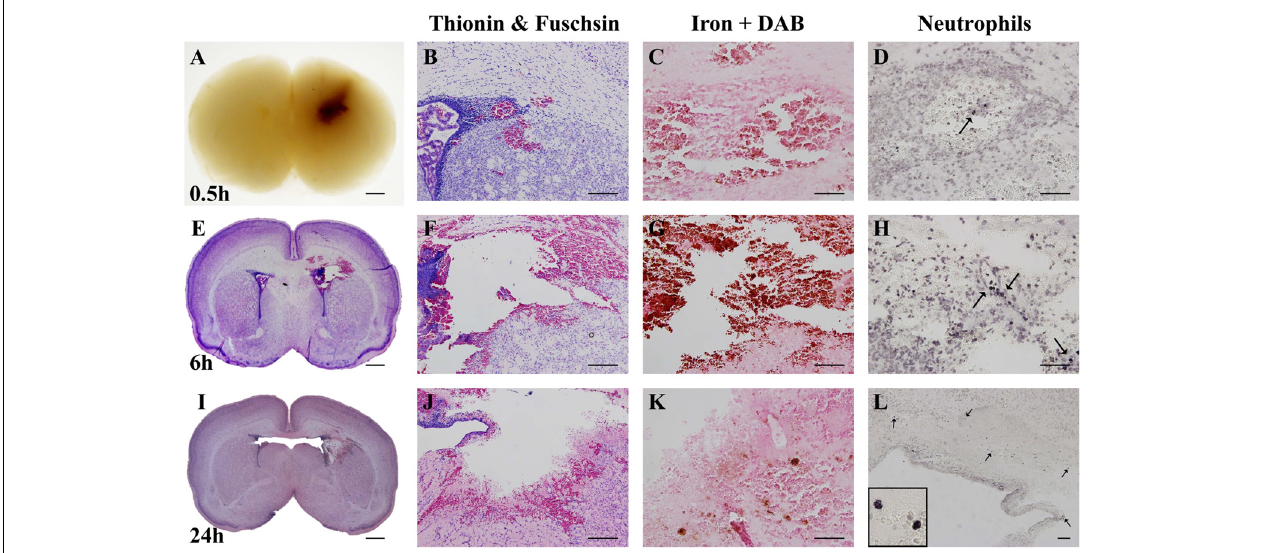
FIGURE 2 | Characterization of optimal collagenase dose. (A) Coronal view of paraffin-embedded rat brain collected 0.5 h after 0.3 U collagenase injection. Representative micrograph of (B) thionin and fuchsin, (C) DAB-enhanced iron and (D) Neutrophil (MPO) stainings showing ipsilateral striatum 0.5 h after 0.3 U collagenase injection ( n = 7). (E) Whole brain (thionin and fuschisin) and ipsilateral striatum level representative micrographs of (F) thionin and fuchsin, (G) DAB-enhanced iron and (H) Neutrophil (MPO) 6 h after 0.3 U collagenase injection ( n = 7). (I) Whole brain (thionin and fuchsin) and ipsilateral striatum level representative micrographs of (J) thionin and fuchsin, (K) DAB-enhanced iron, and (L) Neutrophil (MPO) 24 h after 0.3 U collagenase injection ( n = 12). Scale bar = 1 mm in (A,E,I) ; 100 µ m in all other micrographs. MPO, myeloperoxidase.